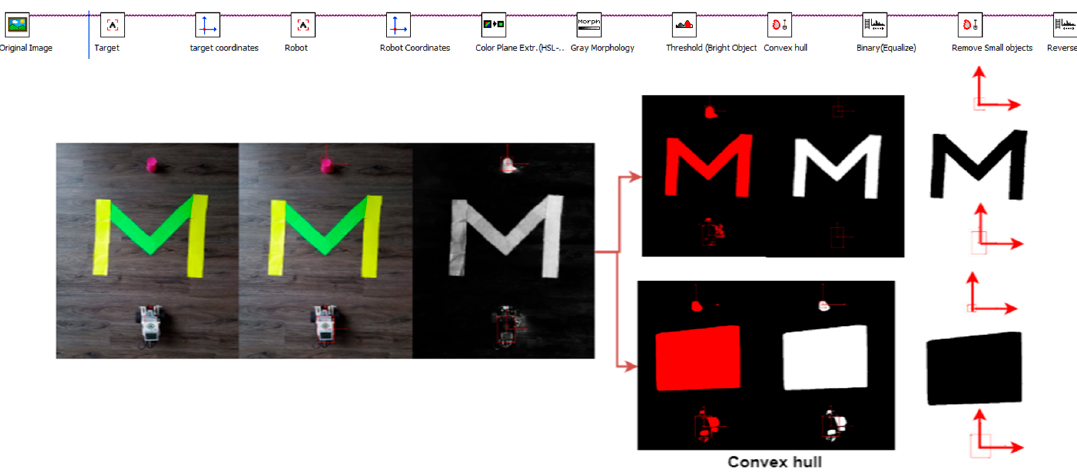
Figure 9. Structure and functionality of vision algorithm (second scenario).